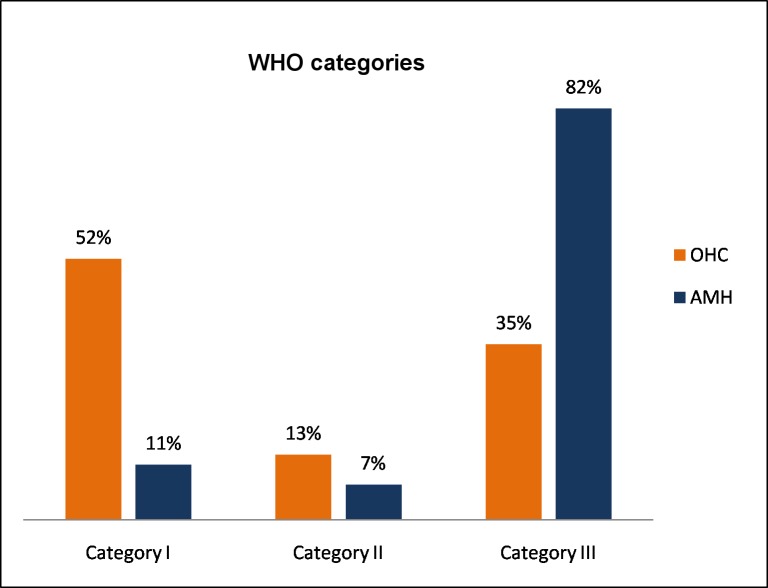
WHO categories of all BU patients with IS2404 PCR positive ulcers enrolled at the PHC and the SHC centers